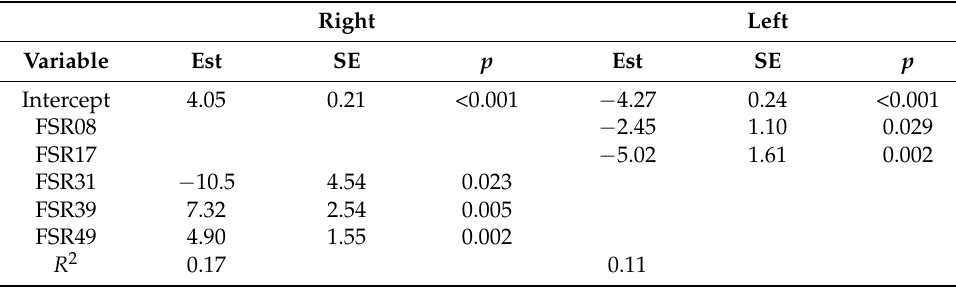
Table 3. Regression models based on one plantar height. Right Left Right